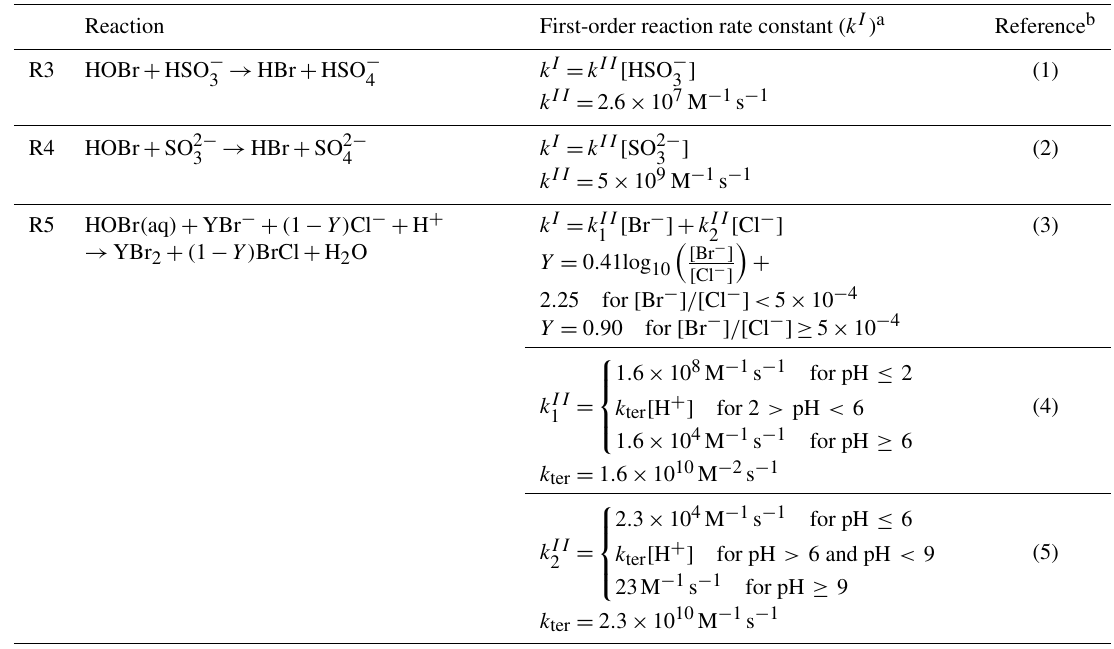
Table 2. First-order reaction rate constants ( k I ) for HOBr heterogeneous reactions in aerosol and liquid cloud water.